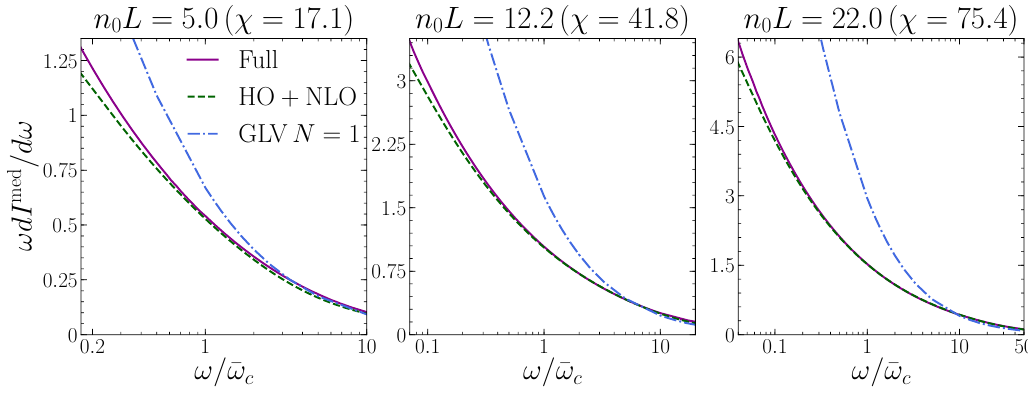
Figure 4 . Fully resummed medium-induced gluon energy distribution for the Yukawa collision rate (magenta solid lines) compared to the HO+NLO (green dashed) and first opacity (blue dash- dotted) approximations as a function of the rescaled gluon energy x = ω/ ¯ ω c for different values of n 0 L (or χ